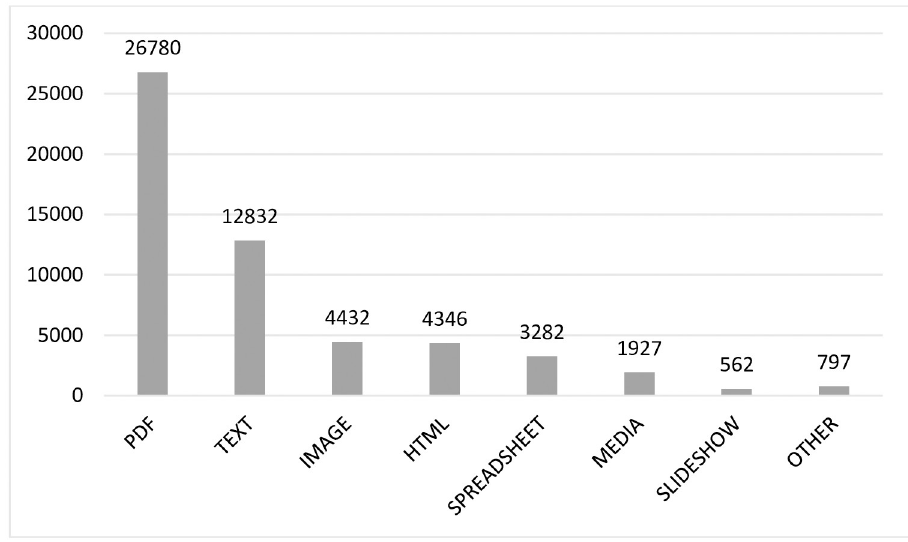
Fig 2. File formats of supplementary material (note that there may be more than one file per